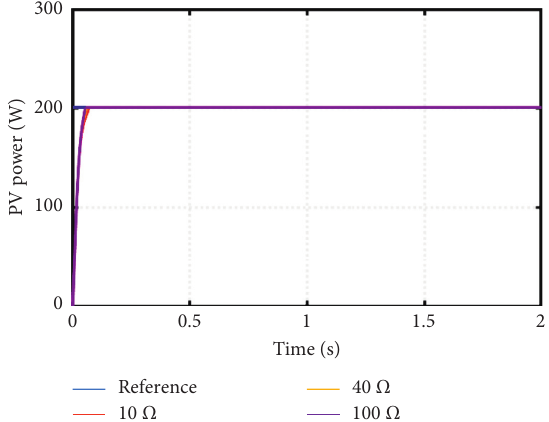
Figure 18: PV power responses for variable load (1000W/m and 45 ° C).